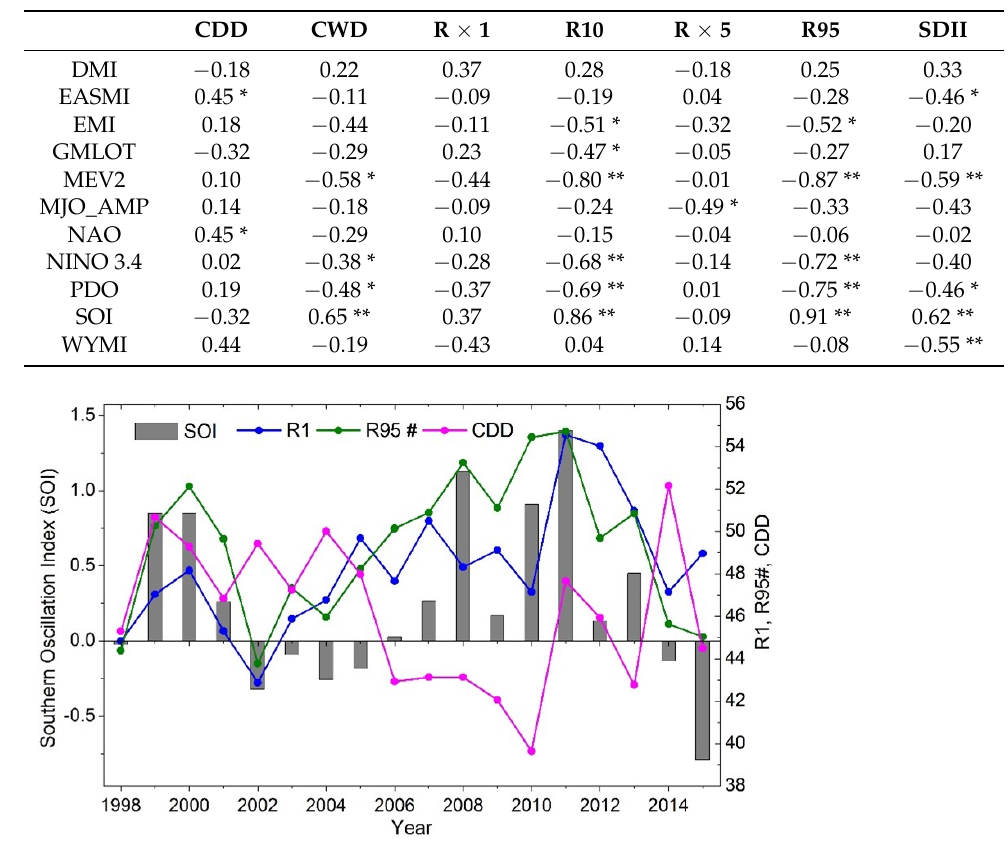
Table 3. Spearman correlation coefficients between precipitation climate change indices and various global teleconnection indices and regional level monsoon indices over monsoon Asia. * is the 0.05 significance level, and ** is the 0.01 significance level. DMI—Dipole Mode Index, EMI—El-Niño